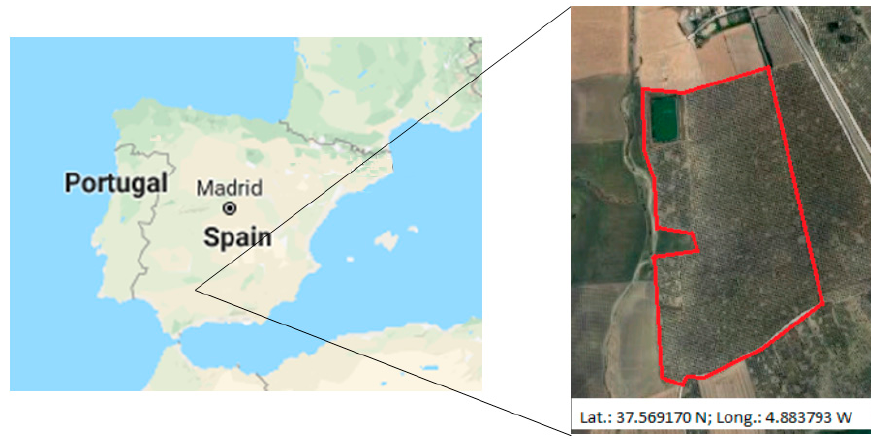
Figure 19. Farm location.